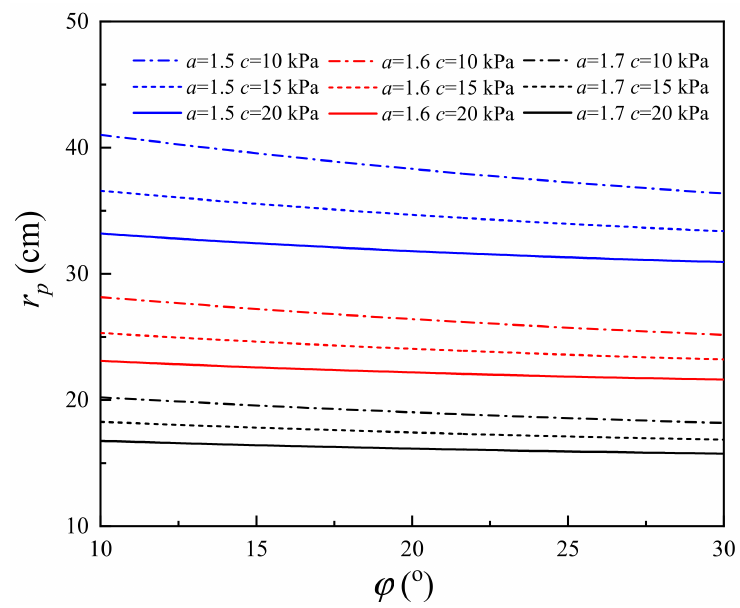
Figure 16. Effect of ϕ on the